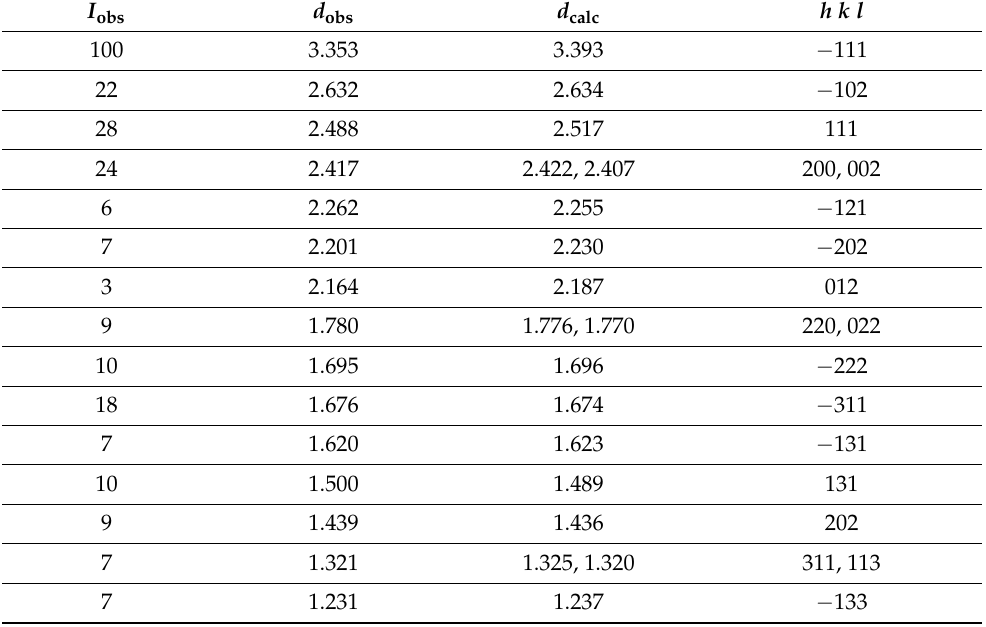
Table 2. Powder X-ray diffraction data ( d in Å) of the manganite-related Zn,Mn-mineral from Kapova